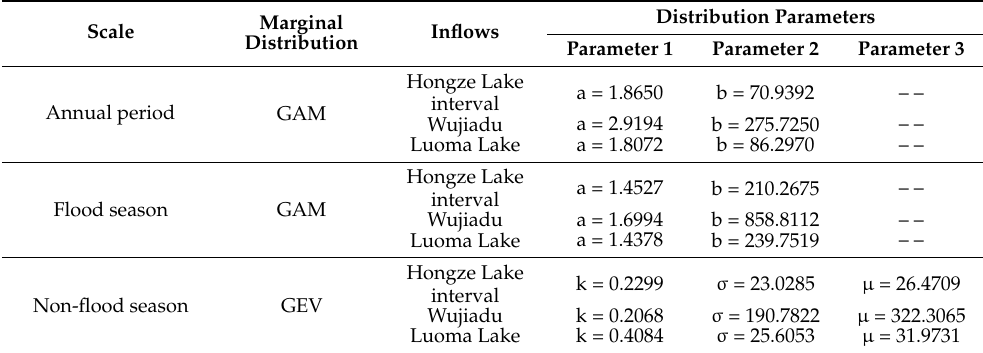
Table 4. Scheme II of the marginal distributions and their distribution parameters.